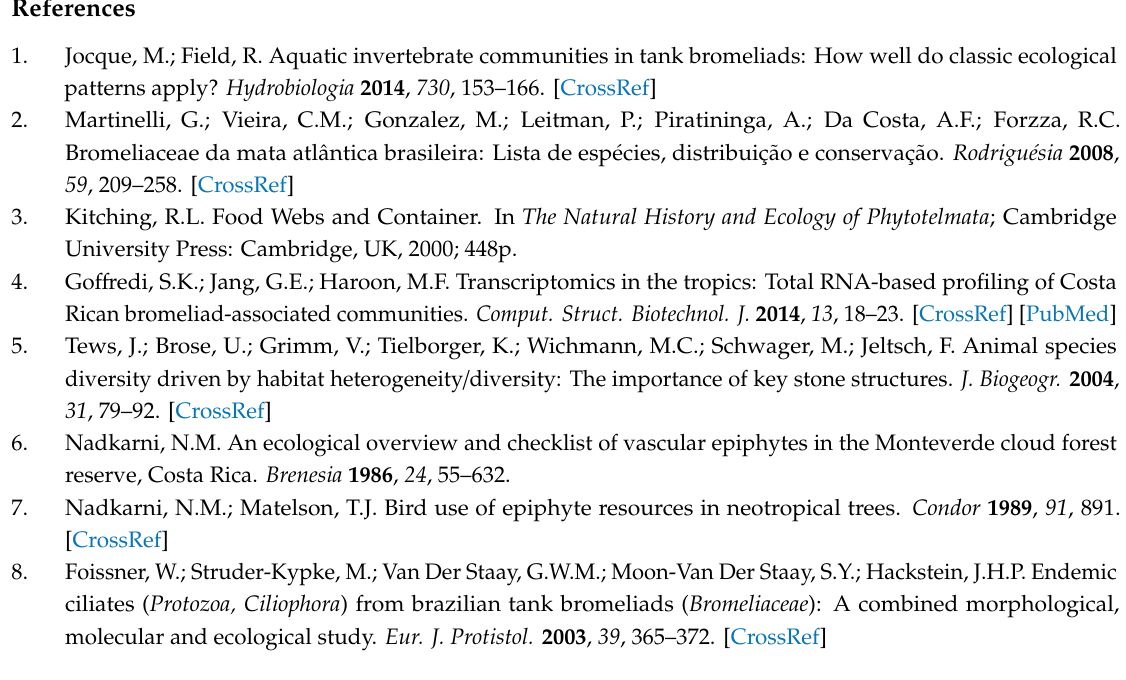
Table S1: List of morphospecies found in the phytotelmata of Vriesea gigantean , Vriesea incurvata , Vriesea platynema , and Vriesea friburgensis during the study